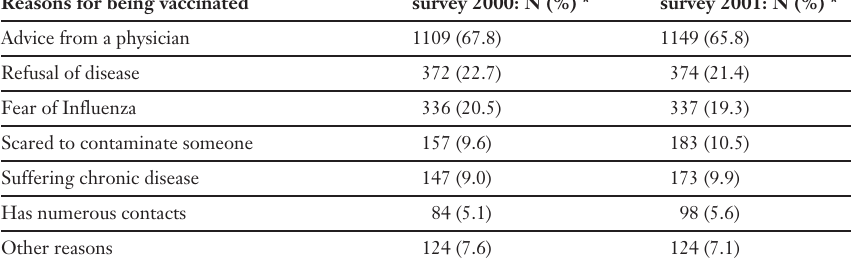
Survey 2000 and 2001: reasons not to be vaccinated, N = 1183 in 2000, and N = 1242 in